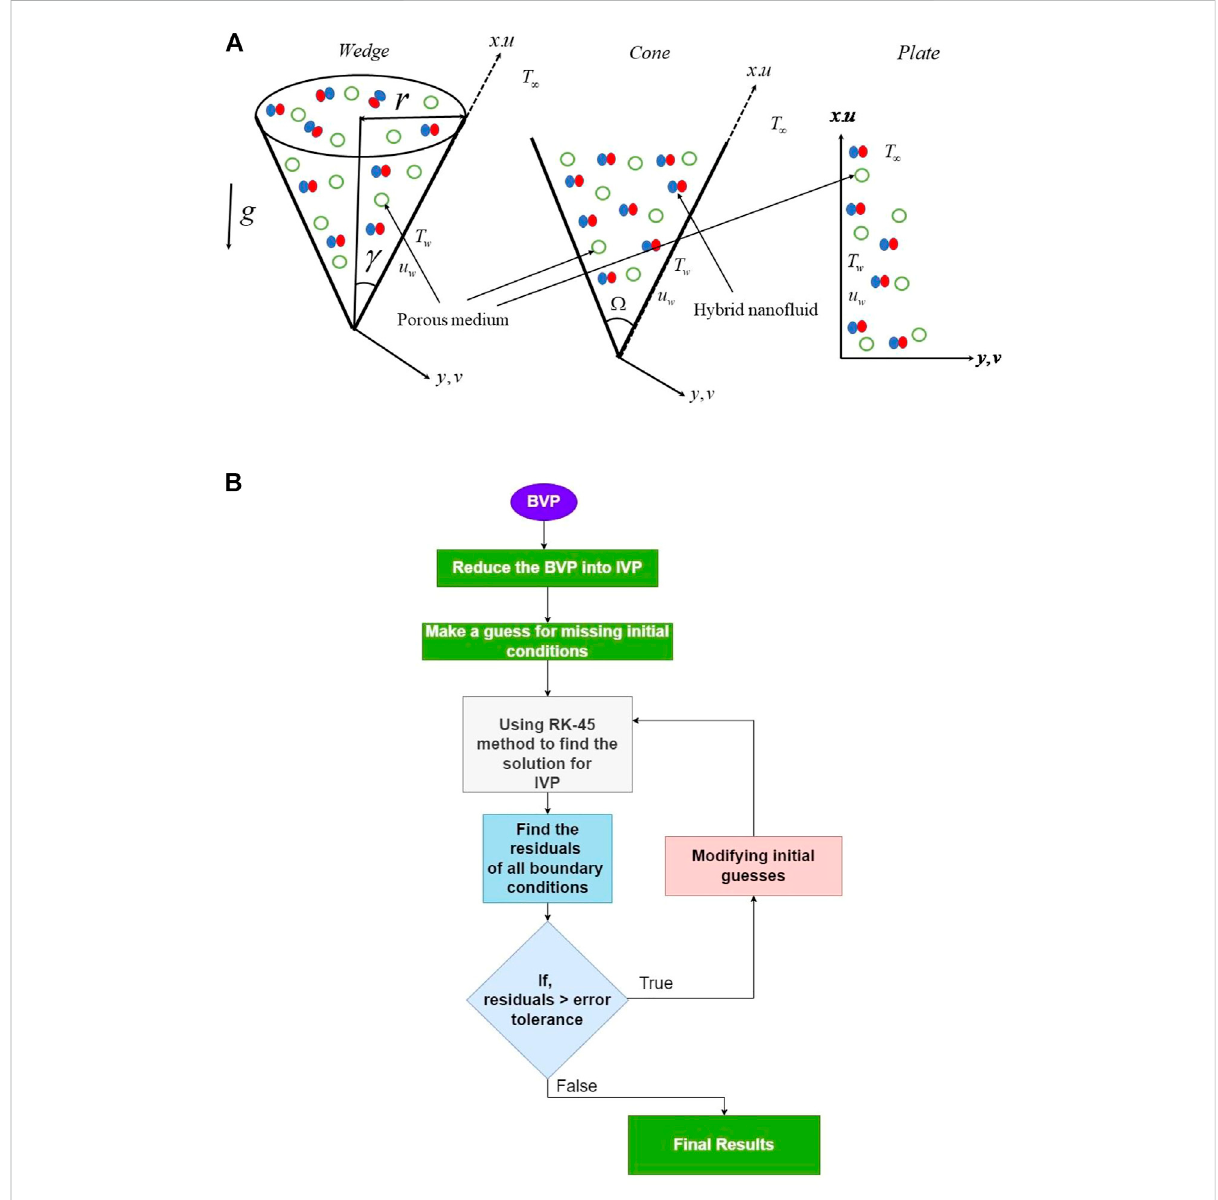
FIGURE 1 (A) Flow geometry. (B) Flow chart of the numerical